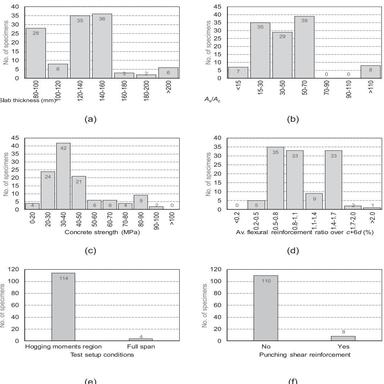
Histograms of tested parameters in monotonic punching tests of flat slab specimens with normal-weight FRC with conventional aggregates, excluding small scale specimens: a) specimen thickness; b) ratio As/Ac; c) concrete strength; d) average flexural reinforcement ratio; e) test setup conditions; f) presence of punching shear reinforcement.